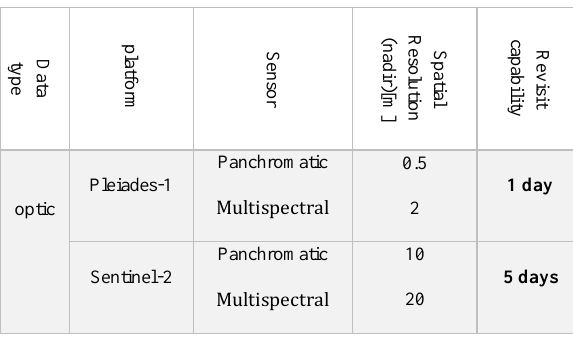
Table1.Technical specifications of the sensors used and